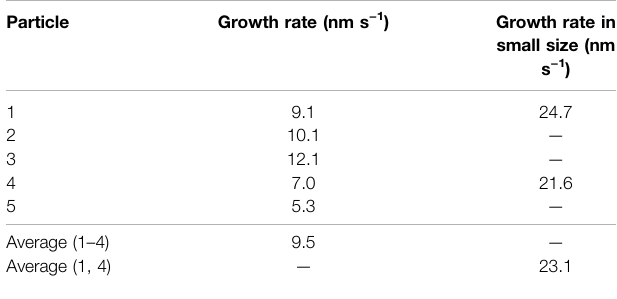
TABLE 5 | Growth rate of each